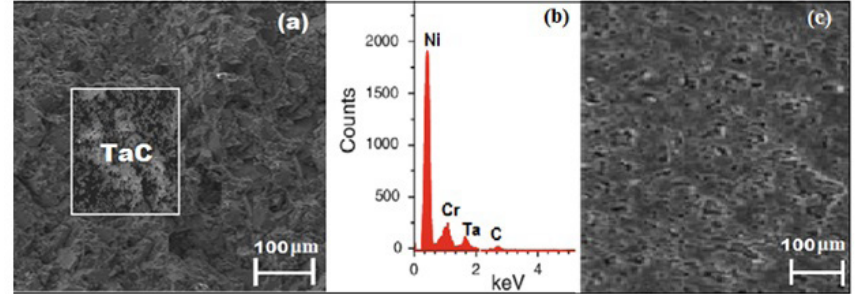
Figure 1. (a) SEM image and (b) EDAX image of chromel composite (c) Distribution of particles.